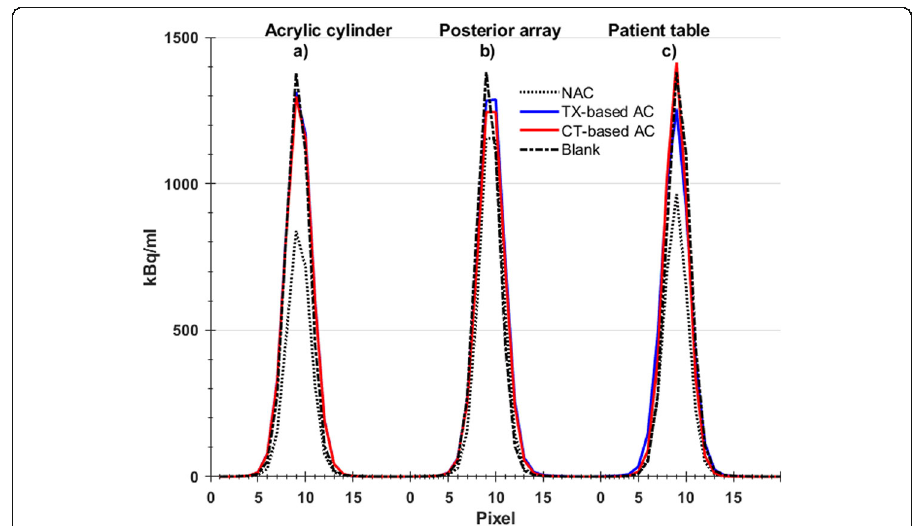
Fig. 3 Line plot of a profile from pixels centred on the PET image produced. For the three-hardware configurations examined in this study, left line plot results from acrylic cylinder with NAC PET, TX-based AC PET, CT-based AC PET, and blank (black-dashed line). The same order of plots is repeated for the posterior array and patient table, respectively